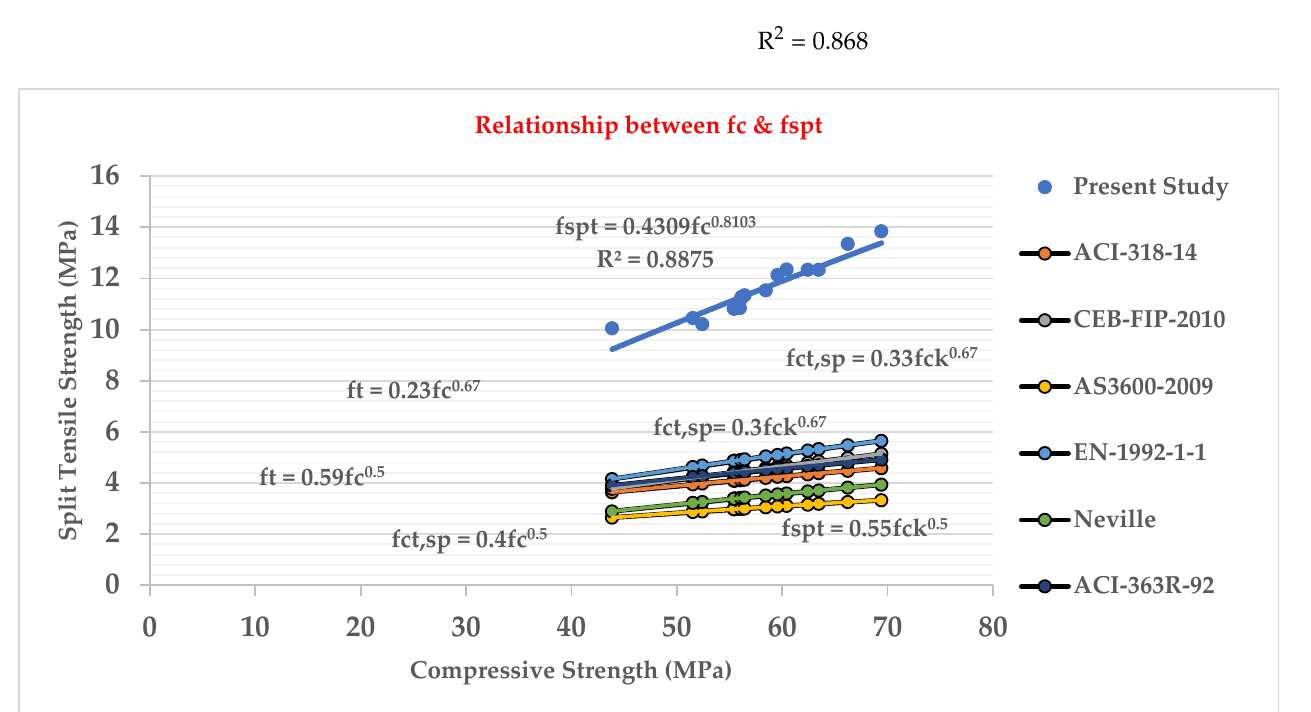
Figure 9. Relation between flexural strength and split tensile strength.